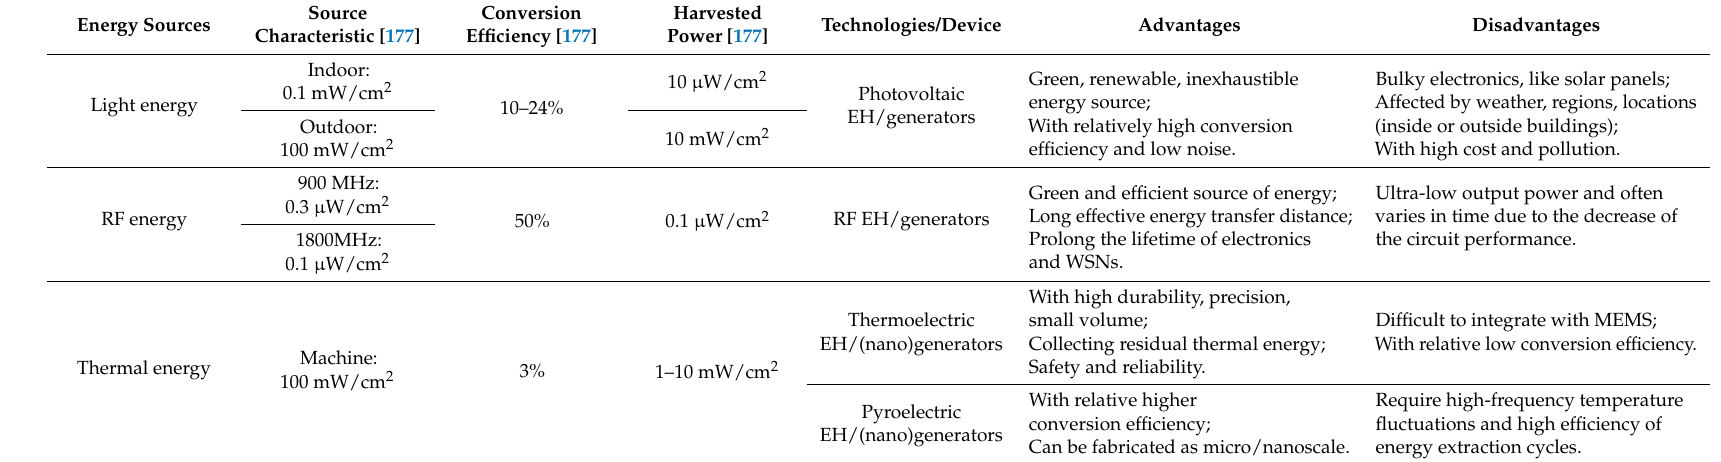
Table 6. Comparison of various energy harvesting